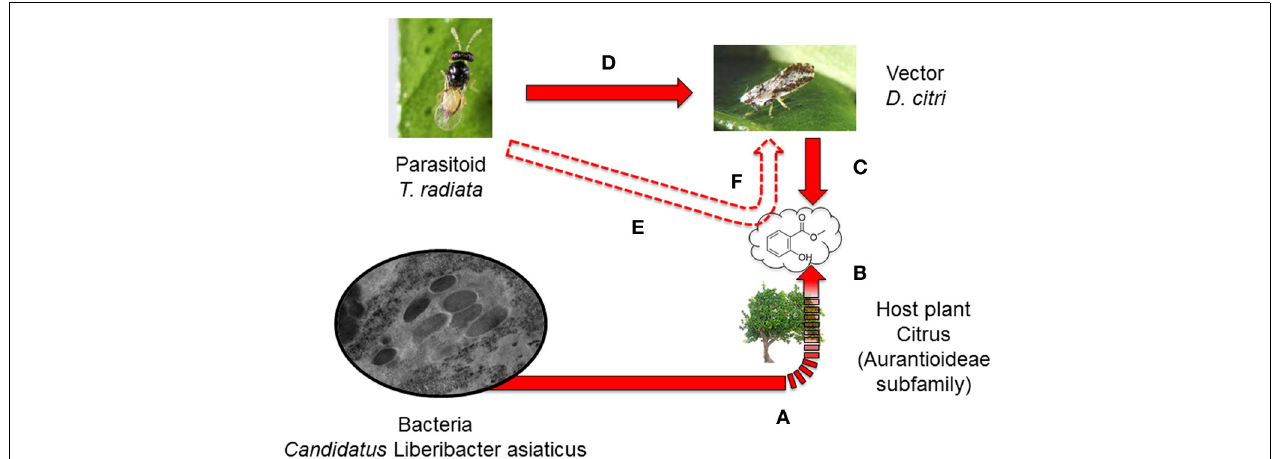
FIGURE 1 | The hypothetical effects of the phytopathogenic bacterium, Candidatus Liberibacter asiaticus (Las), on the behavior of the parasitoid, Tamarixia radiata . Las manipulates the citrus phenotype by: (a) changing the odor profile with increased release of methyl salicylate (b) and consequently causing infected plants to be more attractive to the Las vector, Diaphorina citri , than uninfected counterparts (c). We hypothesized that T.